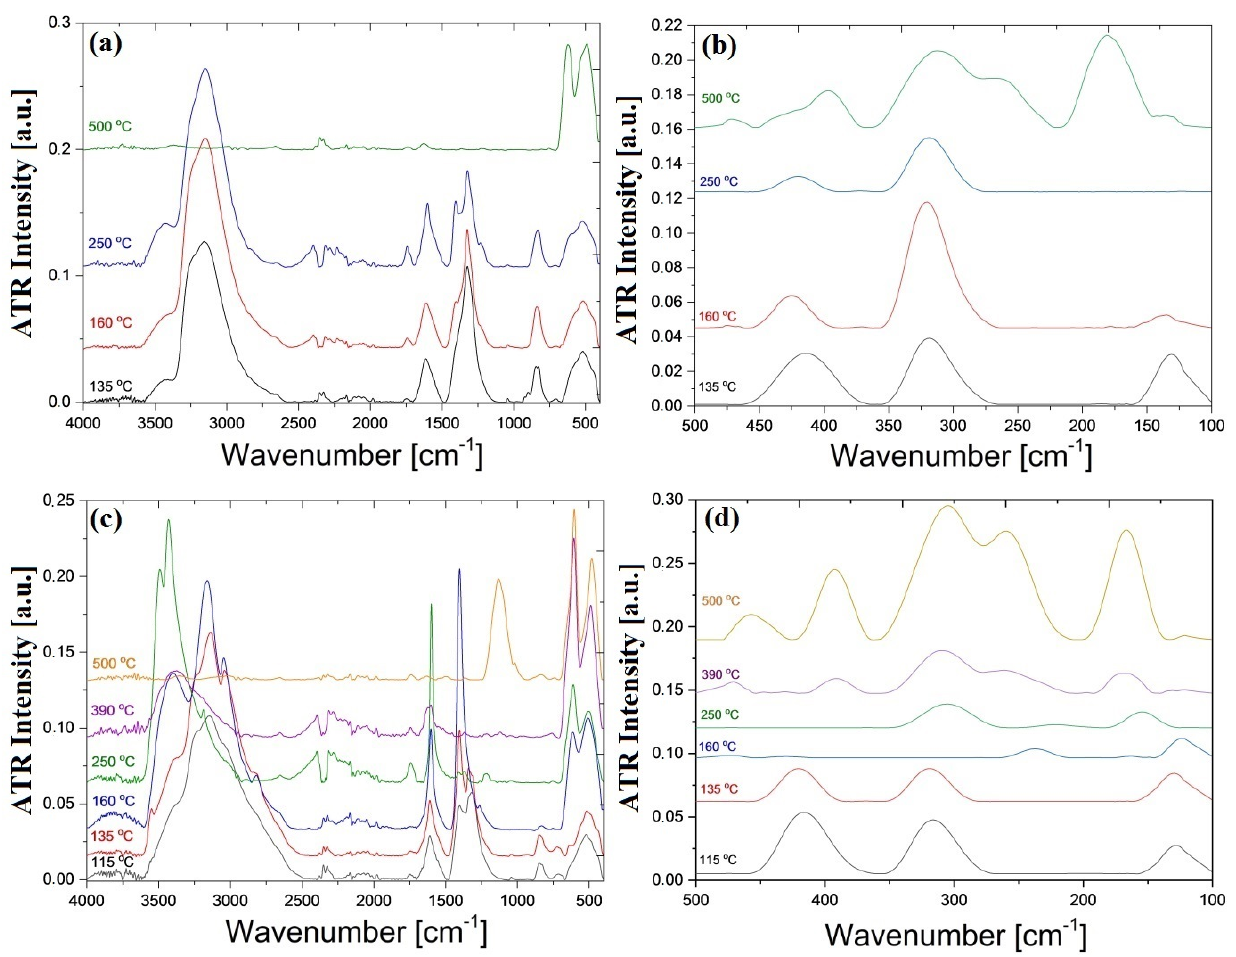
Figure 11. The IR/far − IR spectra of the decomposition intermediates and products of compound 1 in ( a , b ) air and ( c , d ) an inert atmosphere.